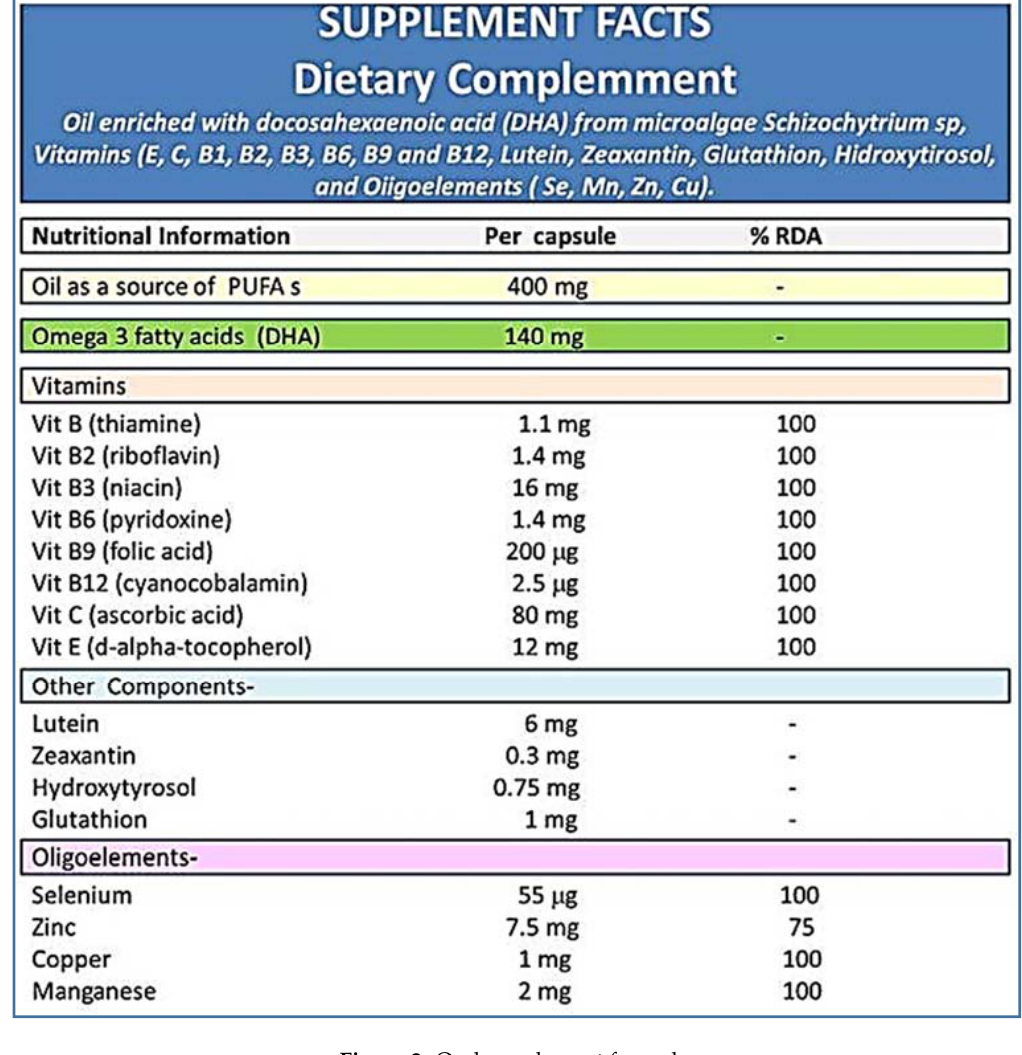
Figure 2. Oral supplement formula.